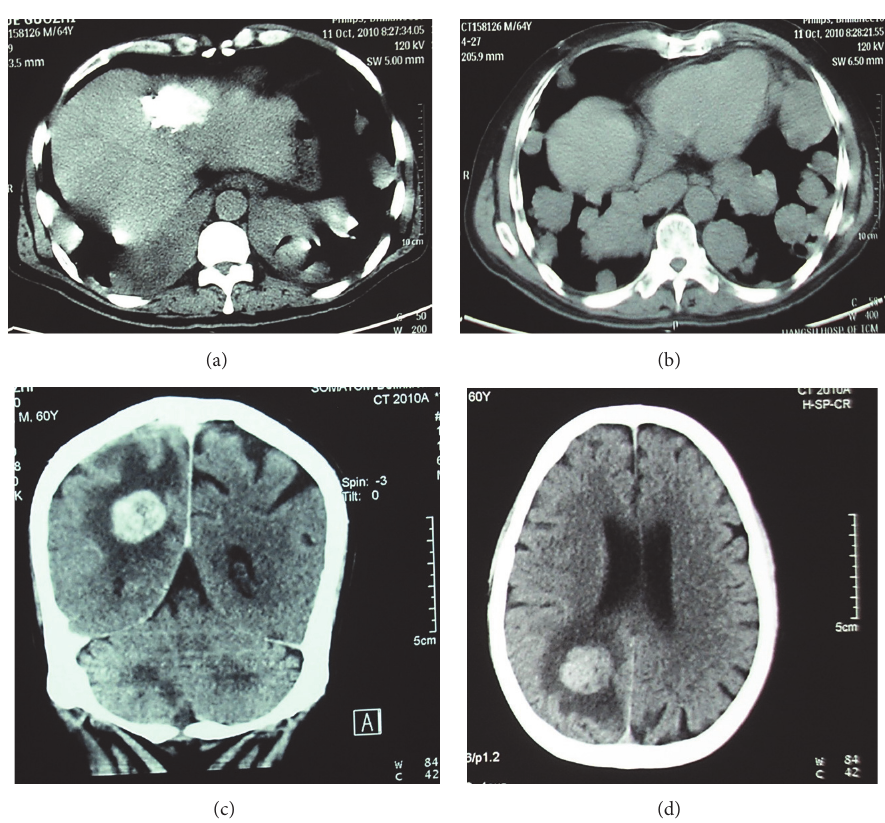
Figure 1: Computerized tomography images of the involved organs. (a) The primary liver mass after the transarterial chemoembolization. (b) Multiple metastases to double lungs. (c and d) Multiple metastases to the